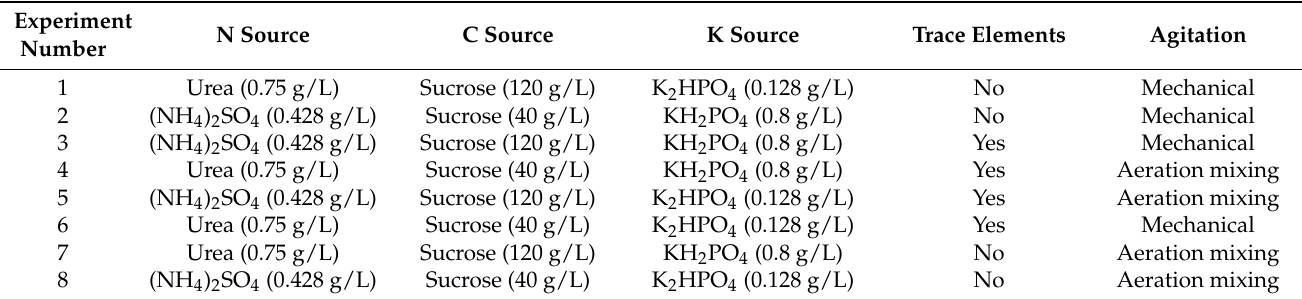
Table 1. Laboratory scale 2 5 − 2 fractional factorial design